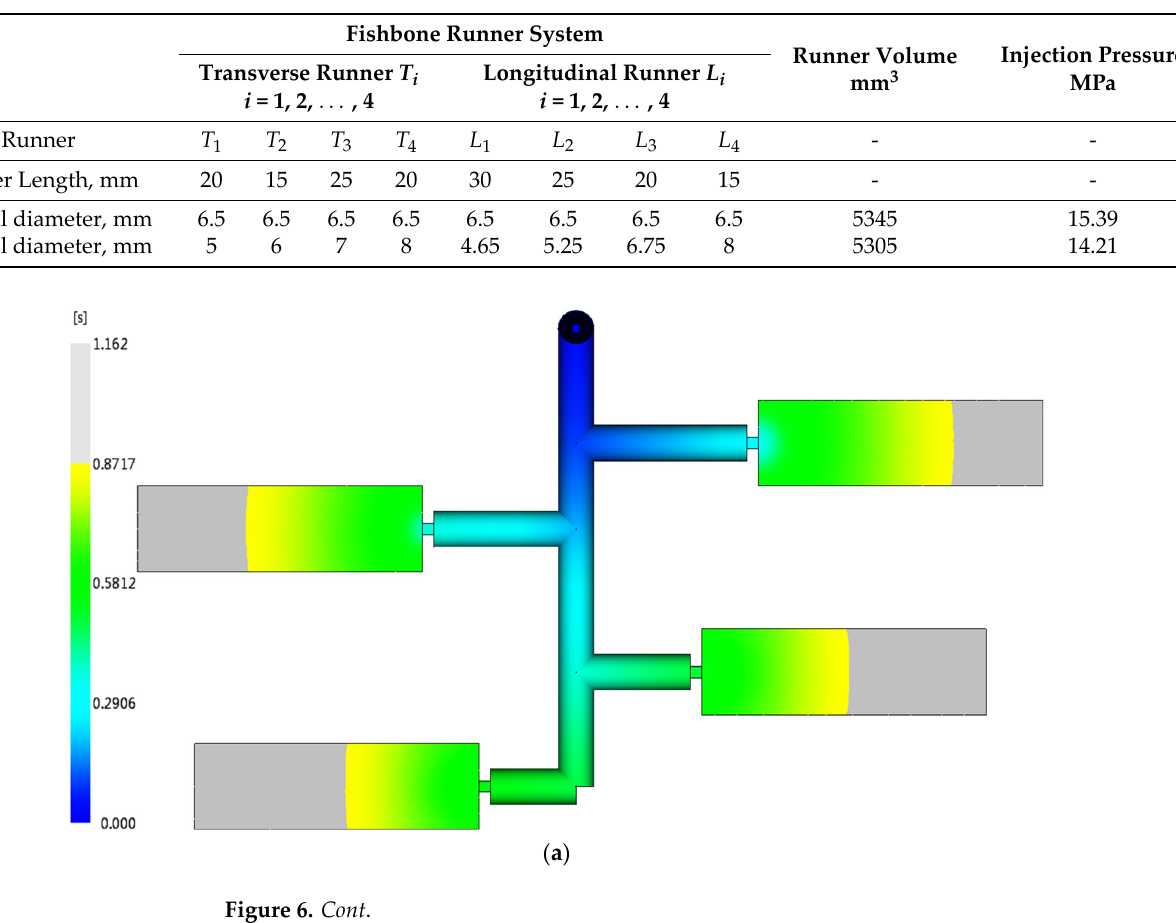
Figure 5. Illustration of 1/2 model of 8-cavity mold with an arbitrary runner layout. Table 2. The runner diameter, volume, and injection pressure of the 8‑cavity mold (a half model) before and after optimization.